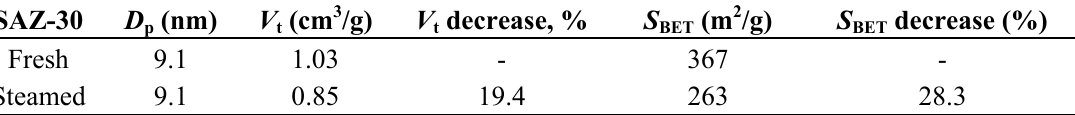
Table 2. Effect of steaming on structural and textural properties of